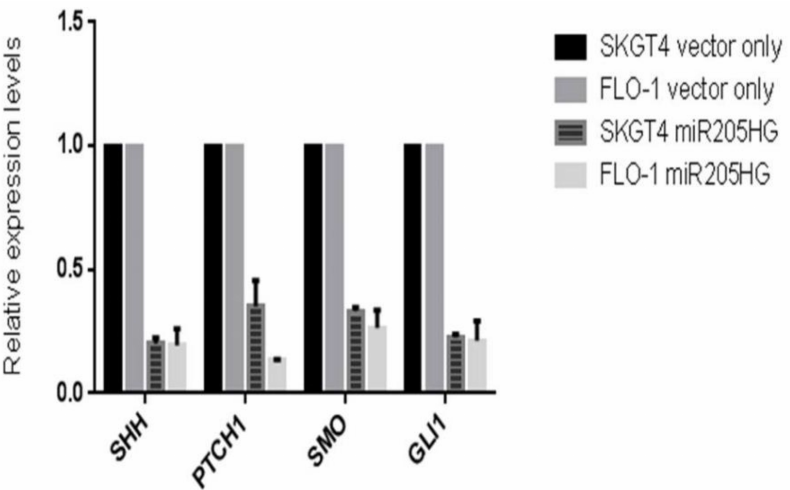
Figure 17. Significant reductions in SHH, PTCH1, SMO, and GLI1 expression levels in miR205HG- stably transfected EAC clones. Relative to vector-only transfected negative control, miR205HG-stably transfected EAC clones exhibited significant reductions in SHH, PTCH1, SMO, and GLI1 expression levels in both SKGT4 and FLO-1 cells ( p -values for all < 0.05).